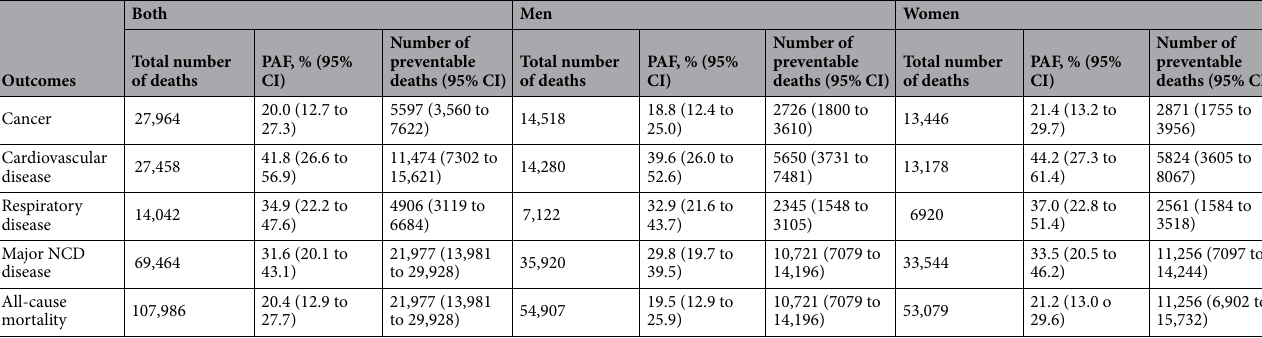
Table 2. Proportion and numbers of deaths from NCD attributable to high body mass index by sex and causes of death in Chile, 2018. Abbreviations: NCD: non-communicable disease; PAF: population attributable fraction.